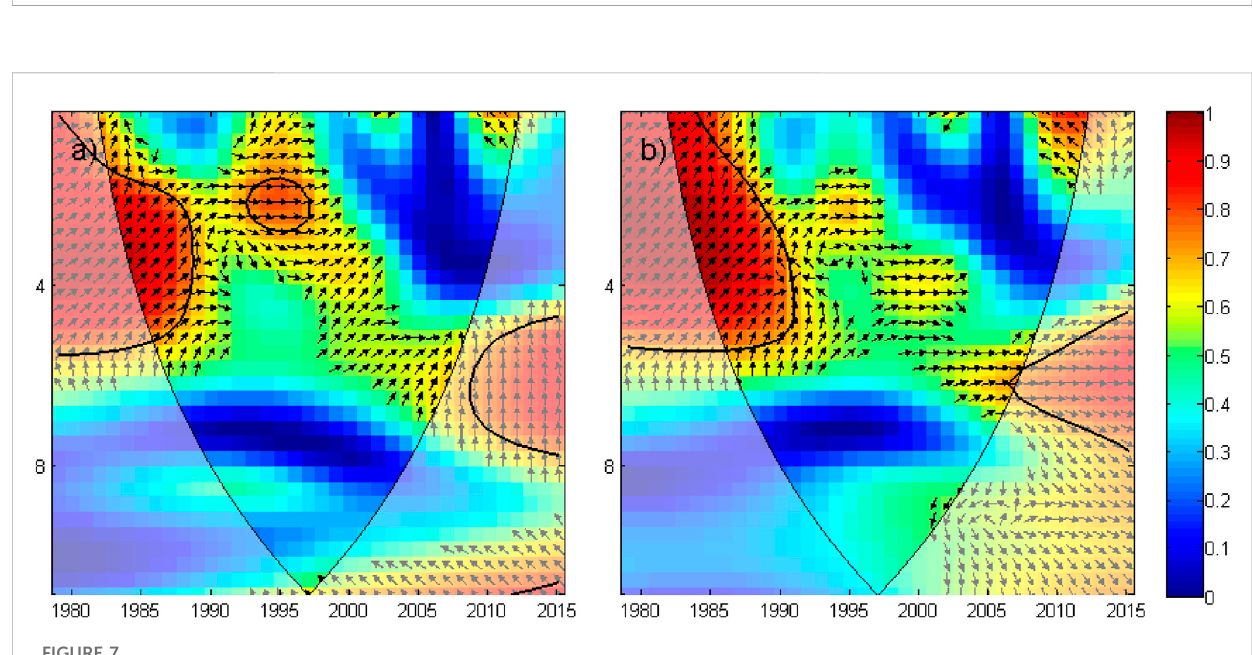
FIGURE 7 Wavelet coherent spectra of annual mean precipitation indices and EASJI over the MLYR from 1979 to 2015: (A) PRCPTOT and EASJI, (B) R25 mm and